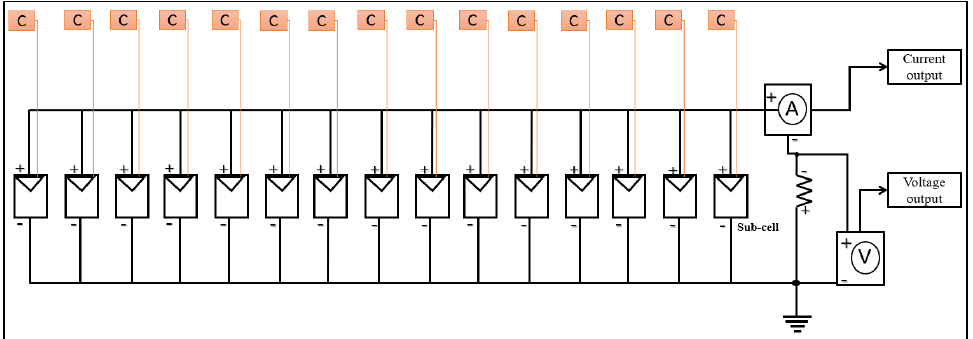
Figure 3. Solar Cell Simulink Model.